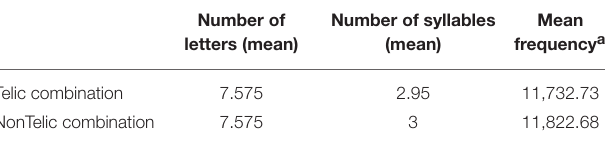
TABLE 2 | Features of the cue words in Telic and NonTelic combinations.